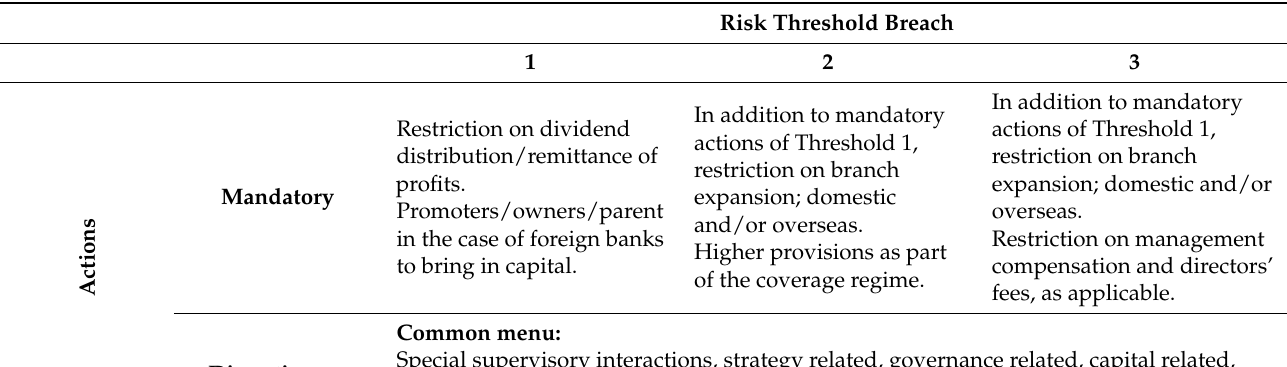
Table A3. PCA Framework—Mandatory and Discretionary Actions (13 April 2017).